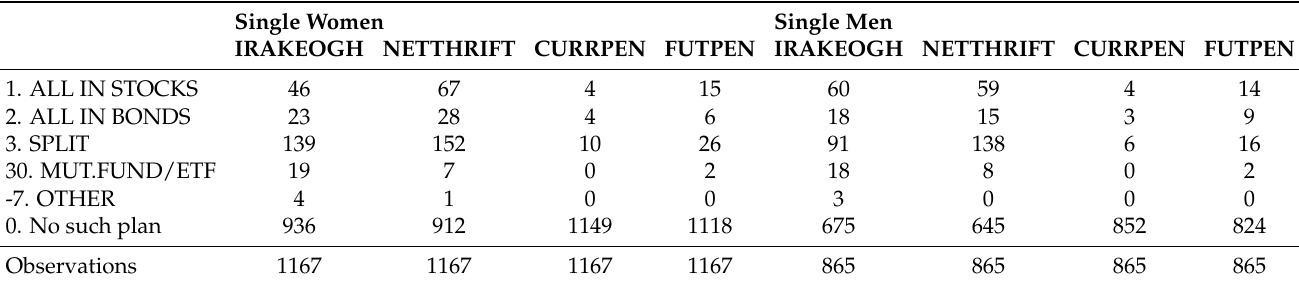
Table 5. How Do Single Women and Single Men Invest Their Retirement Wealth? By “Single” we Refer to “Never Married”, “Divorced”, and “Widowed”